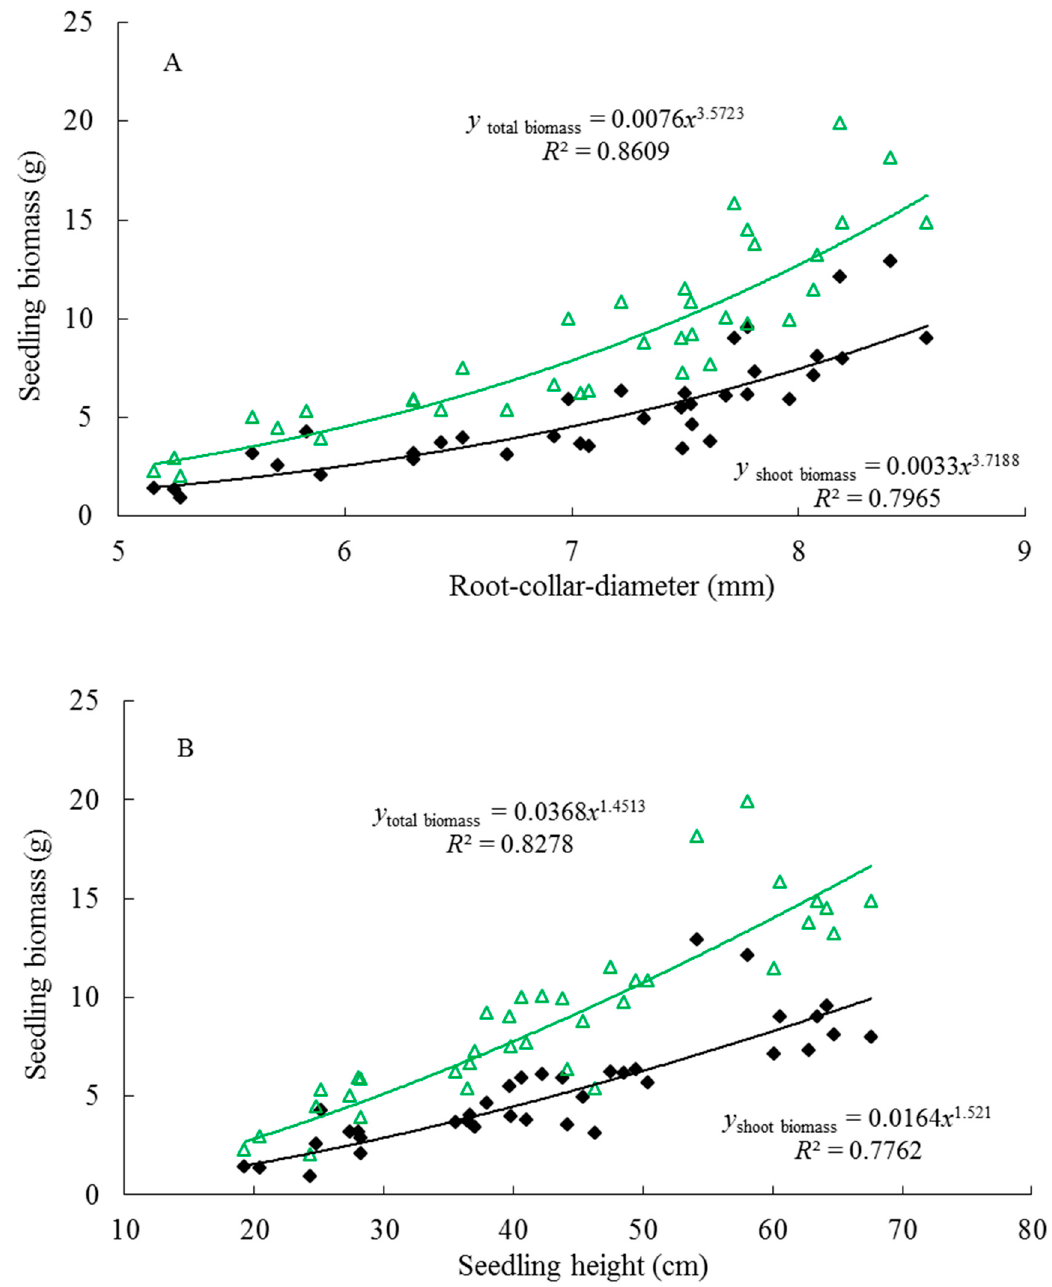
Figure 3. The relationship of seedling biomass with root-collar diameter ( A ) and height ( B ) of Cyclocarya paliurus seedlings ( n = 36).